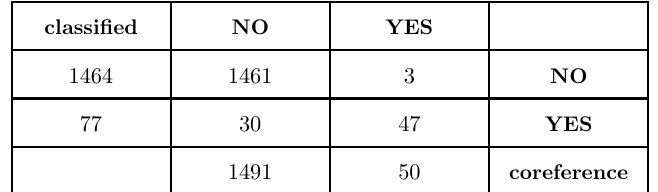
Table 3. Confusion matrix on training set